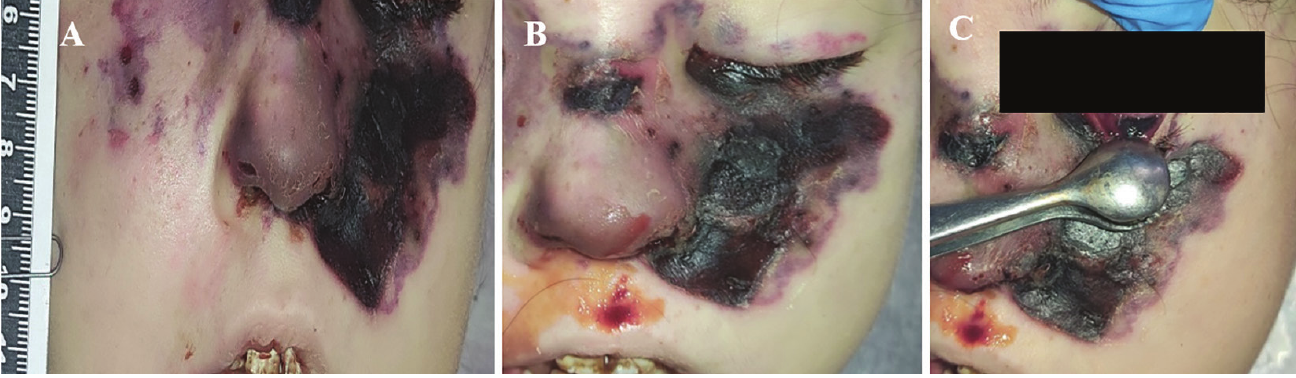
Figure 2 - Photomicrograph of a histological examination of necrotic nasal cavity tissue with a cluster of mucormycosis bacilli, fungal hyphae of mucormycosis. Hematoxylin and eosin, x 200.